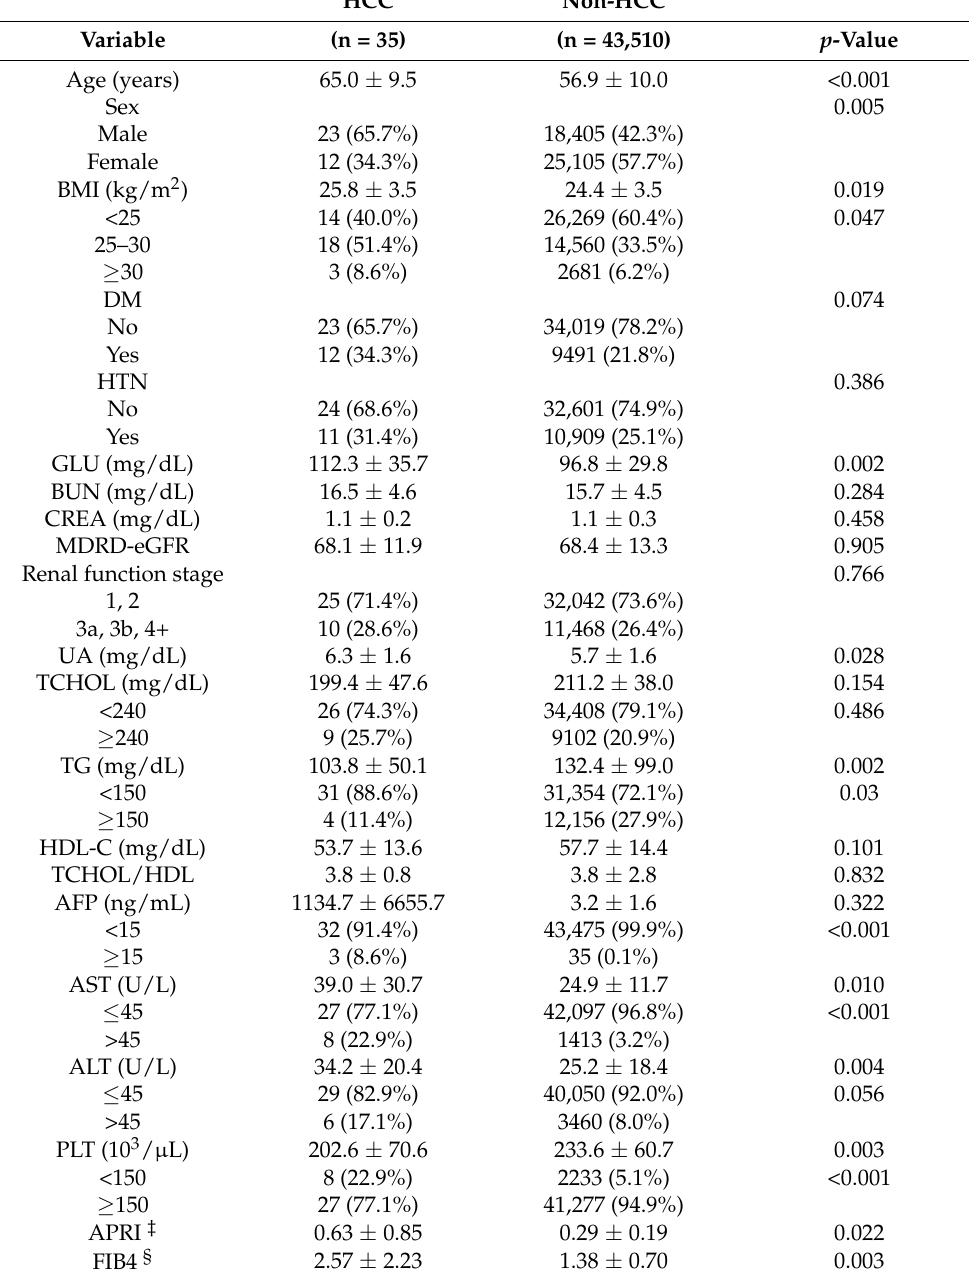
Table 1. Clinical characteristics of enrolled non-B, non-C